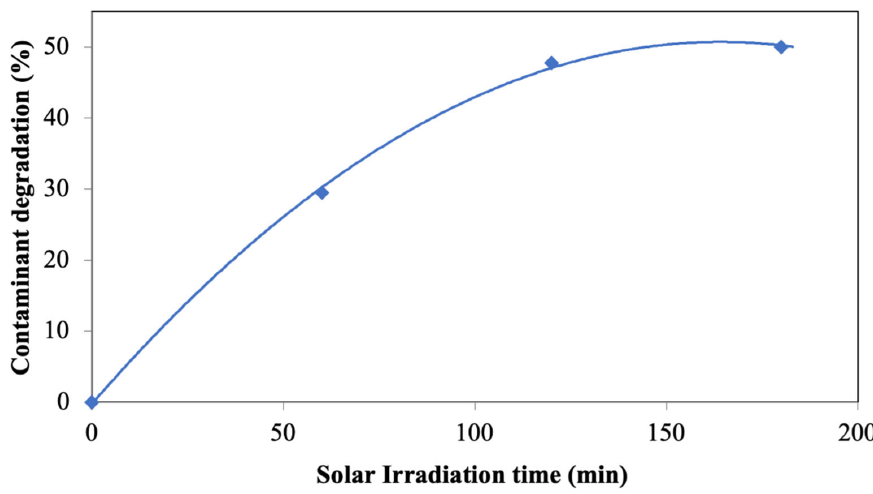
Figure 14. Wastewater decontamination by photocatalysis in photoreactor system using solar irradiation with packed bed configuration for photocatalyst.